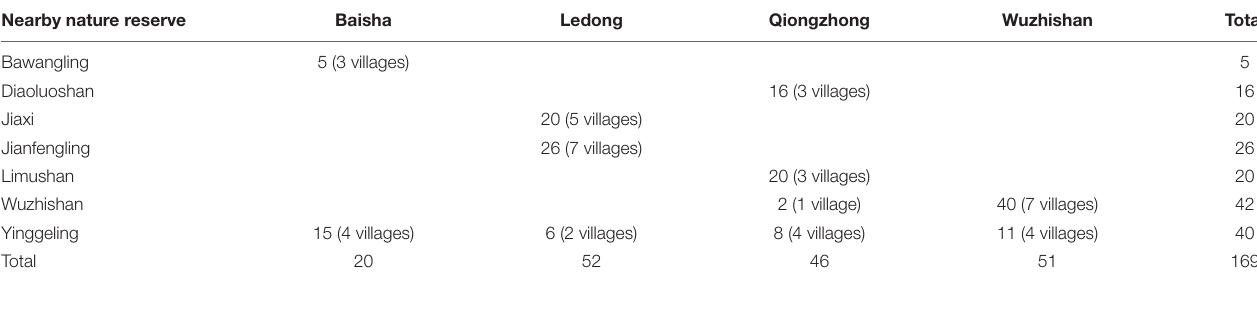
TABLE 1 | Number of interviewees grouped by reserve and administrative